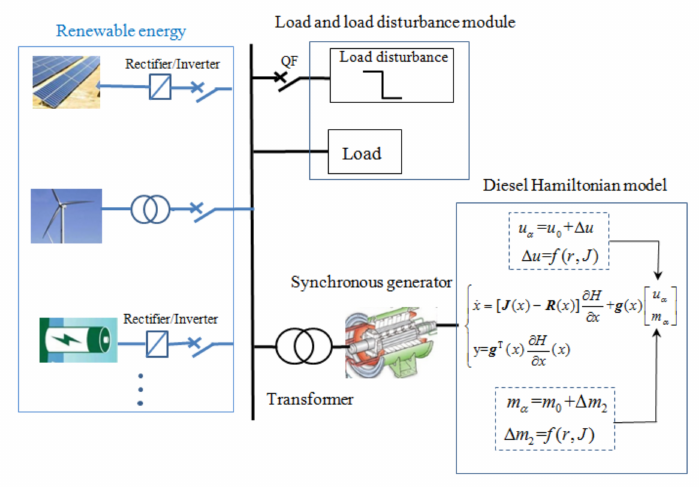
Figure 2. Simulation system diagram.